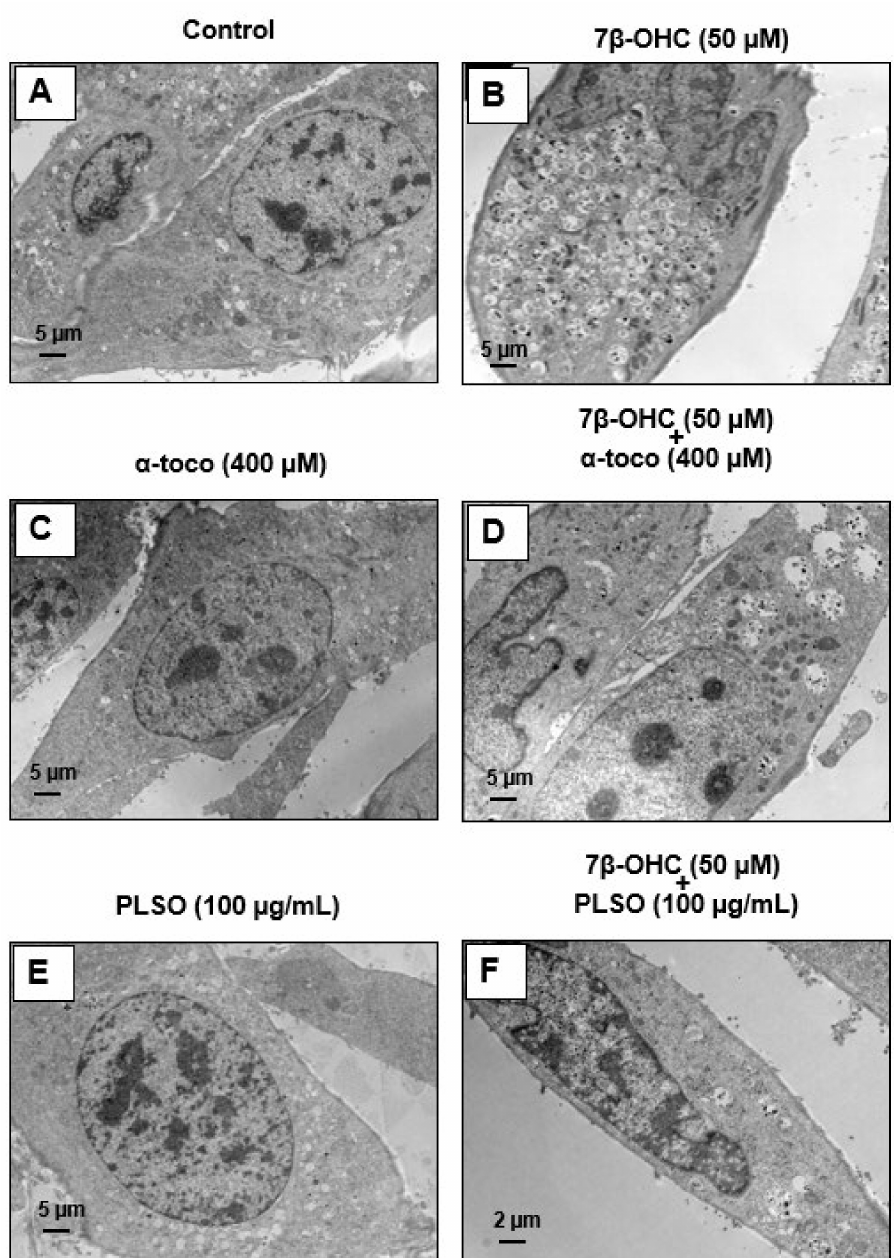
Figure 9. Analysis of morphological changes in C2C12 myoblasts using transmission electron microscopy. C2C12 cells were incubated for 24 h with or without 7 β -OHC (50 µ M) in the presence or absence of PLSO (100 µ g/mL) or α -tocopherol (400 µ M). In untreated cells (control) ( A ), α -tocopherol (400 µ M)-treated cells ( C ), and PLSO (100 µ g/mL)-treated cells ( E ), cells have a fusiform shape, with large round central nuclei containing several nucleoli; they have several small empty vacuoles and morphologically normal mitochondria and peroxisomes. In the 7 β -OHC (50 µ M)-treated cells ( B ), cells have an abnormal morphology: they have a round shape, irregular nuclei, and a lot of cytoplas- mic vacuoles containing cell debris, as well as altered mitochondria and peroxisomes. In (7 β -OHC + α -tocopherol and 7 β -OHC+ PLSO)-treated cells, mainly morphologically normal cells were observed; they contain empty vacuoles and have mainly mitochondria and peroxisomes resembling those present in the control cells ( D–F ). No differences were observed between the control ( A ), α -tocopherol- treated ( C ), and PLSO-treated cells ( E ). Representative TEM images of the C2C12 myoblasts cultured in the presence of the vehicles are shown in Supplementary Figure